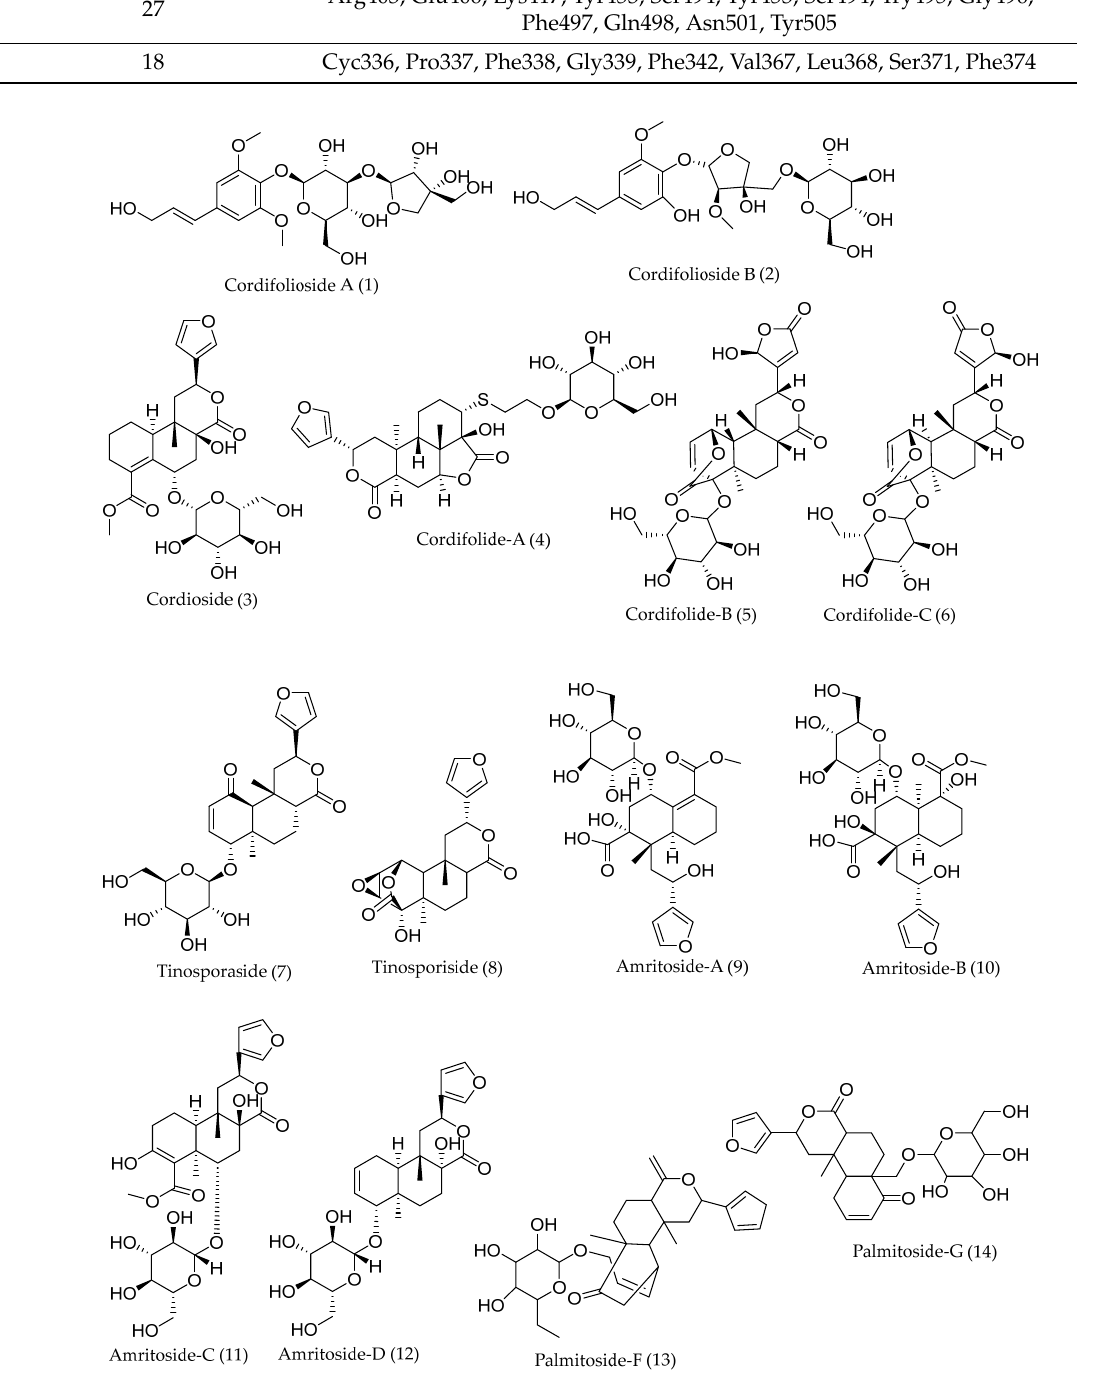
Figure 4. Chemical structures of secondary metabolites with antiviral activities from T. cordifolia .